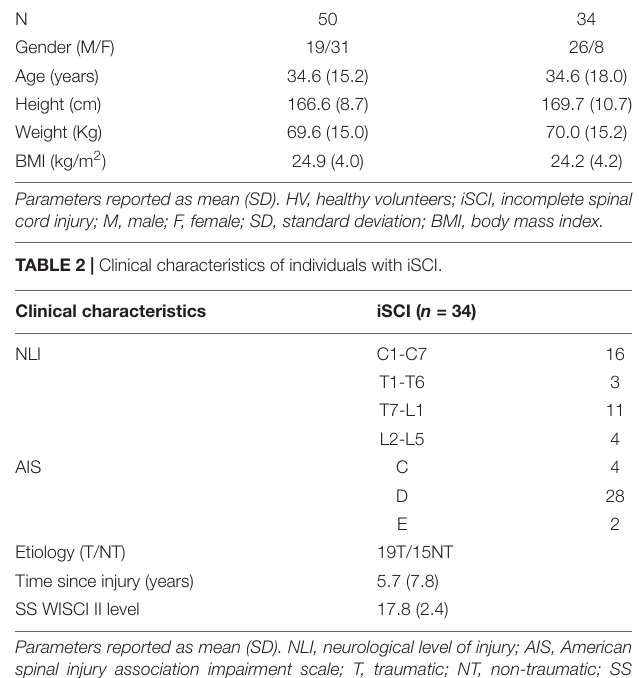
TABLE 1 | Characteristics of individuals recruited for the study. HV iSCI